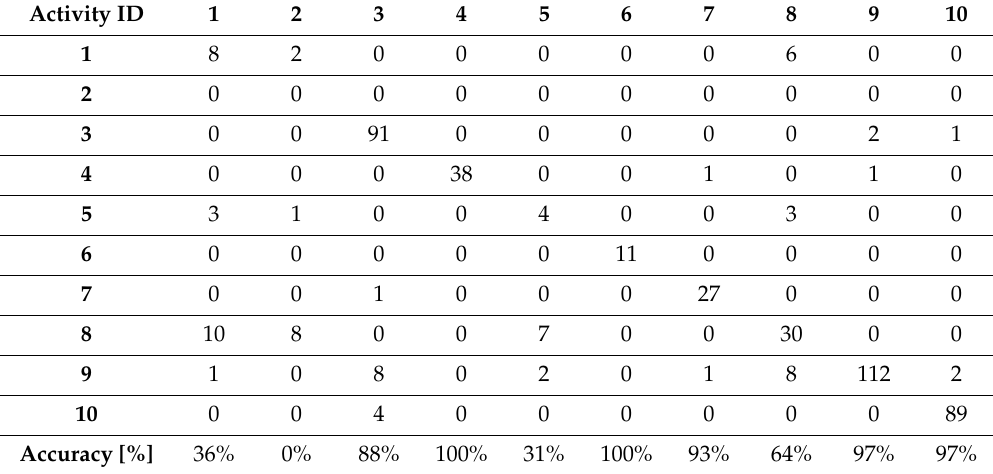
Table 7. Confusion matrix of the localized generalization error-based RBF method (RBF_LGEM) on dataset OrdonezB. The activity ID from 1 to 10 represents breakfast, dinner, grooming, leaving, lunch, showering, sleeping, snack, watching TV, toileting, respectively. Rows represent the inferred activity and columns represent the actual